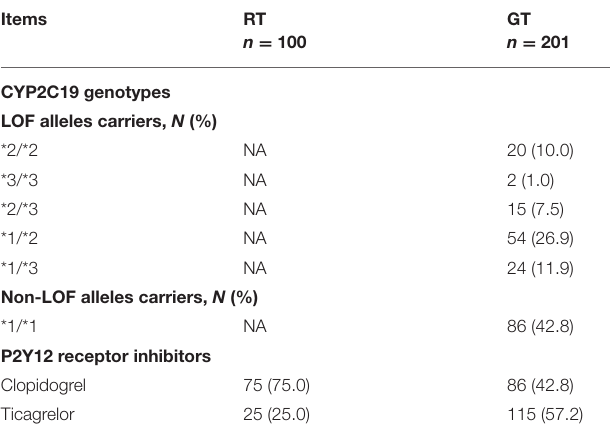
TABLE 2 | CYP2C19 genotypes distribution and P2Y 12 receptor inhibitors selection.